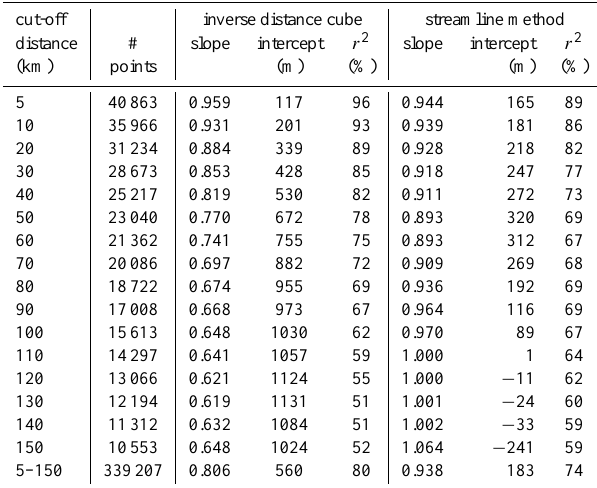
Skill and robustness of the streamline interpolation method. The slope and intercept of the linear fit of estimated ice thickness as a function of observed ice thickness is given as a func- tion of the distance to the nearest data point. r 2 is the square of Pearson’s correlation